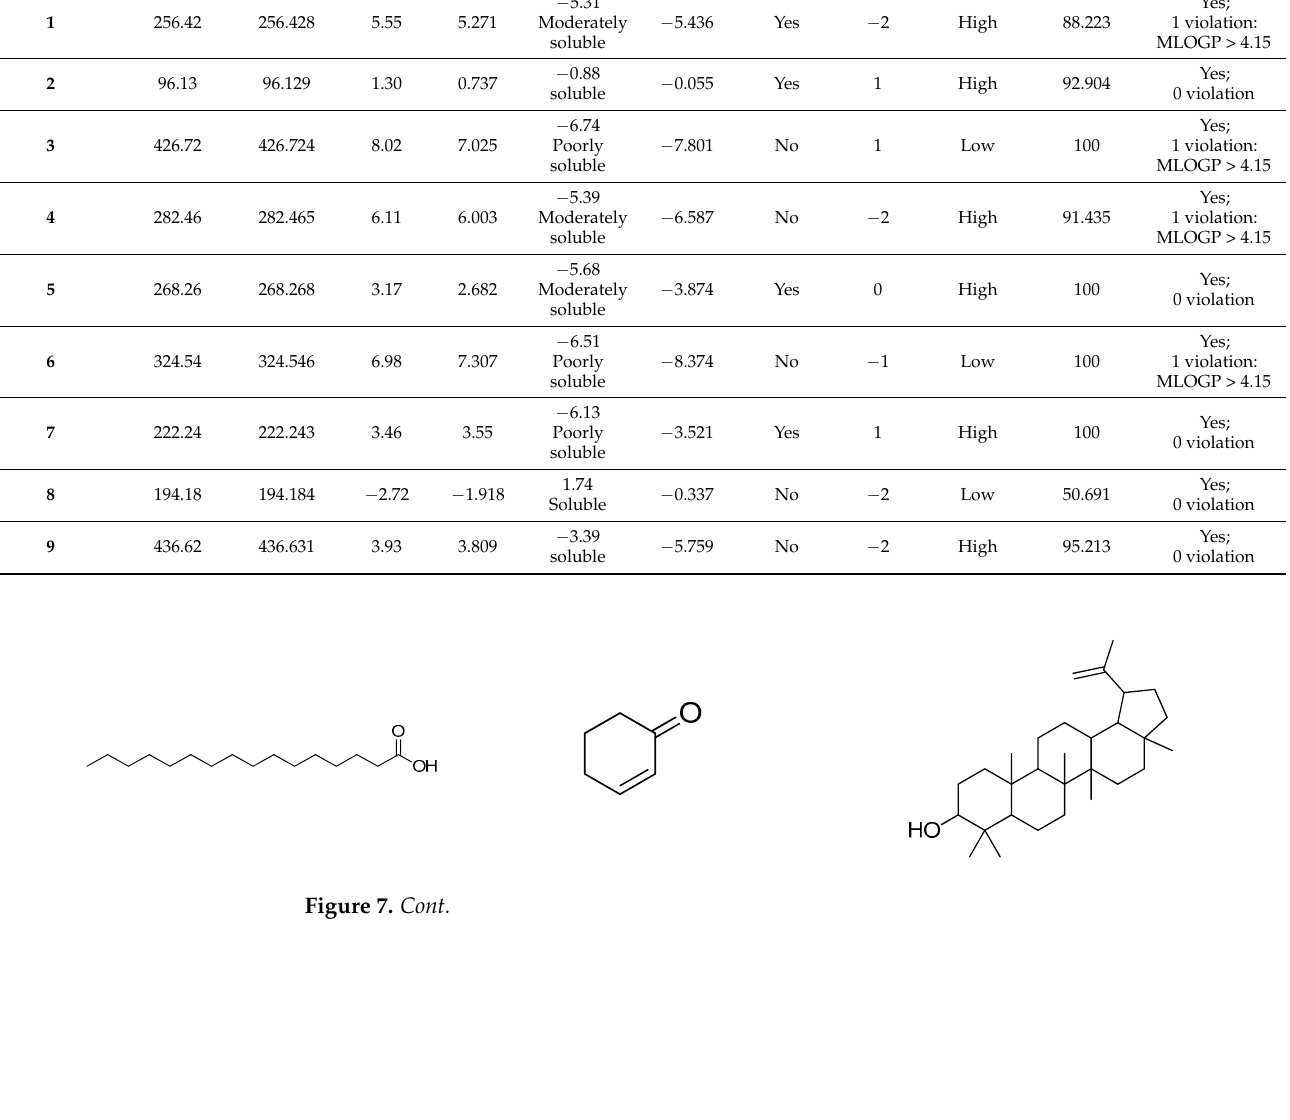
Table 4. Predicted ADME properties for identified bioactive BERM-derived metabolites using Swis- sADME and QikProp tools.